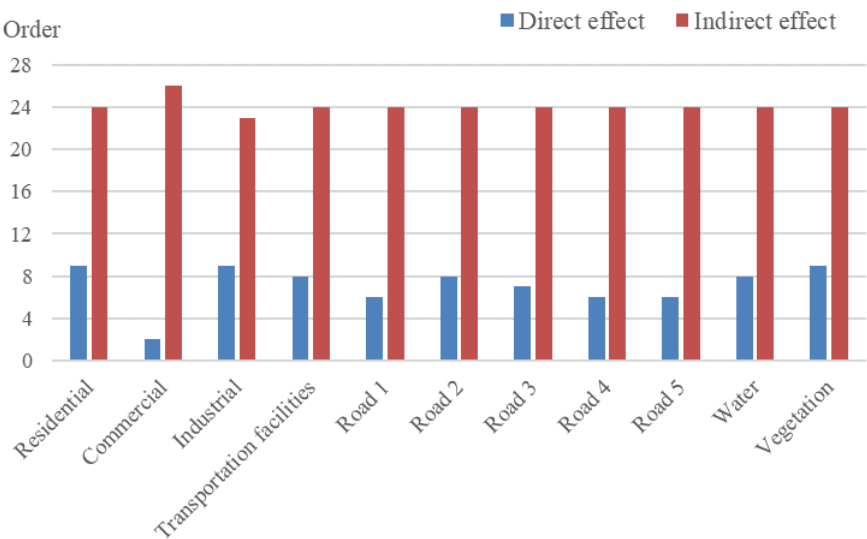
Figure 8. The attenuation distance of the direct effect and the indirect effect.